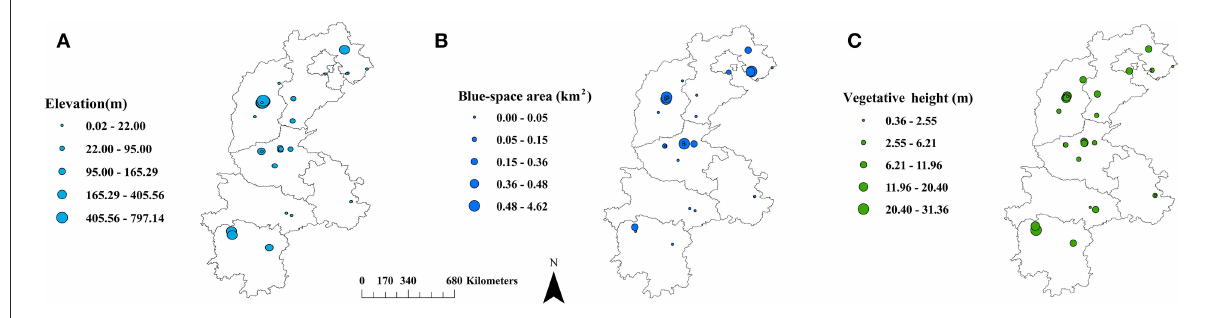
FIGURE5 Spatial distributions of landscape metrics in elevation (A) , blue-space area (B) , and vegetative height (C) for urban wetland parks in Central China.